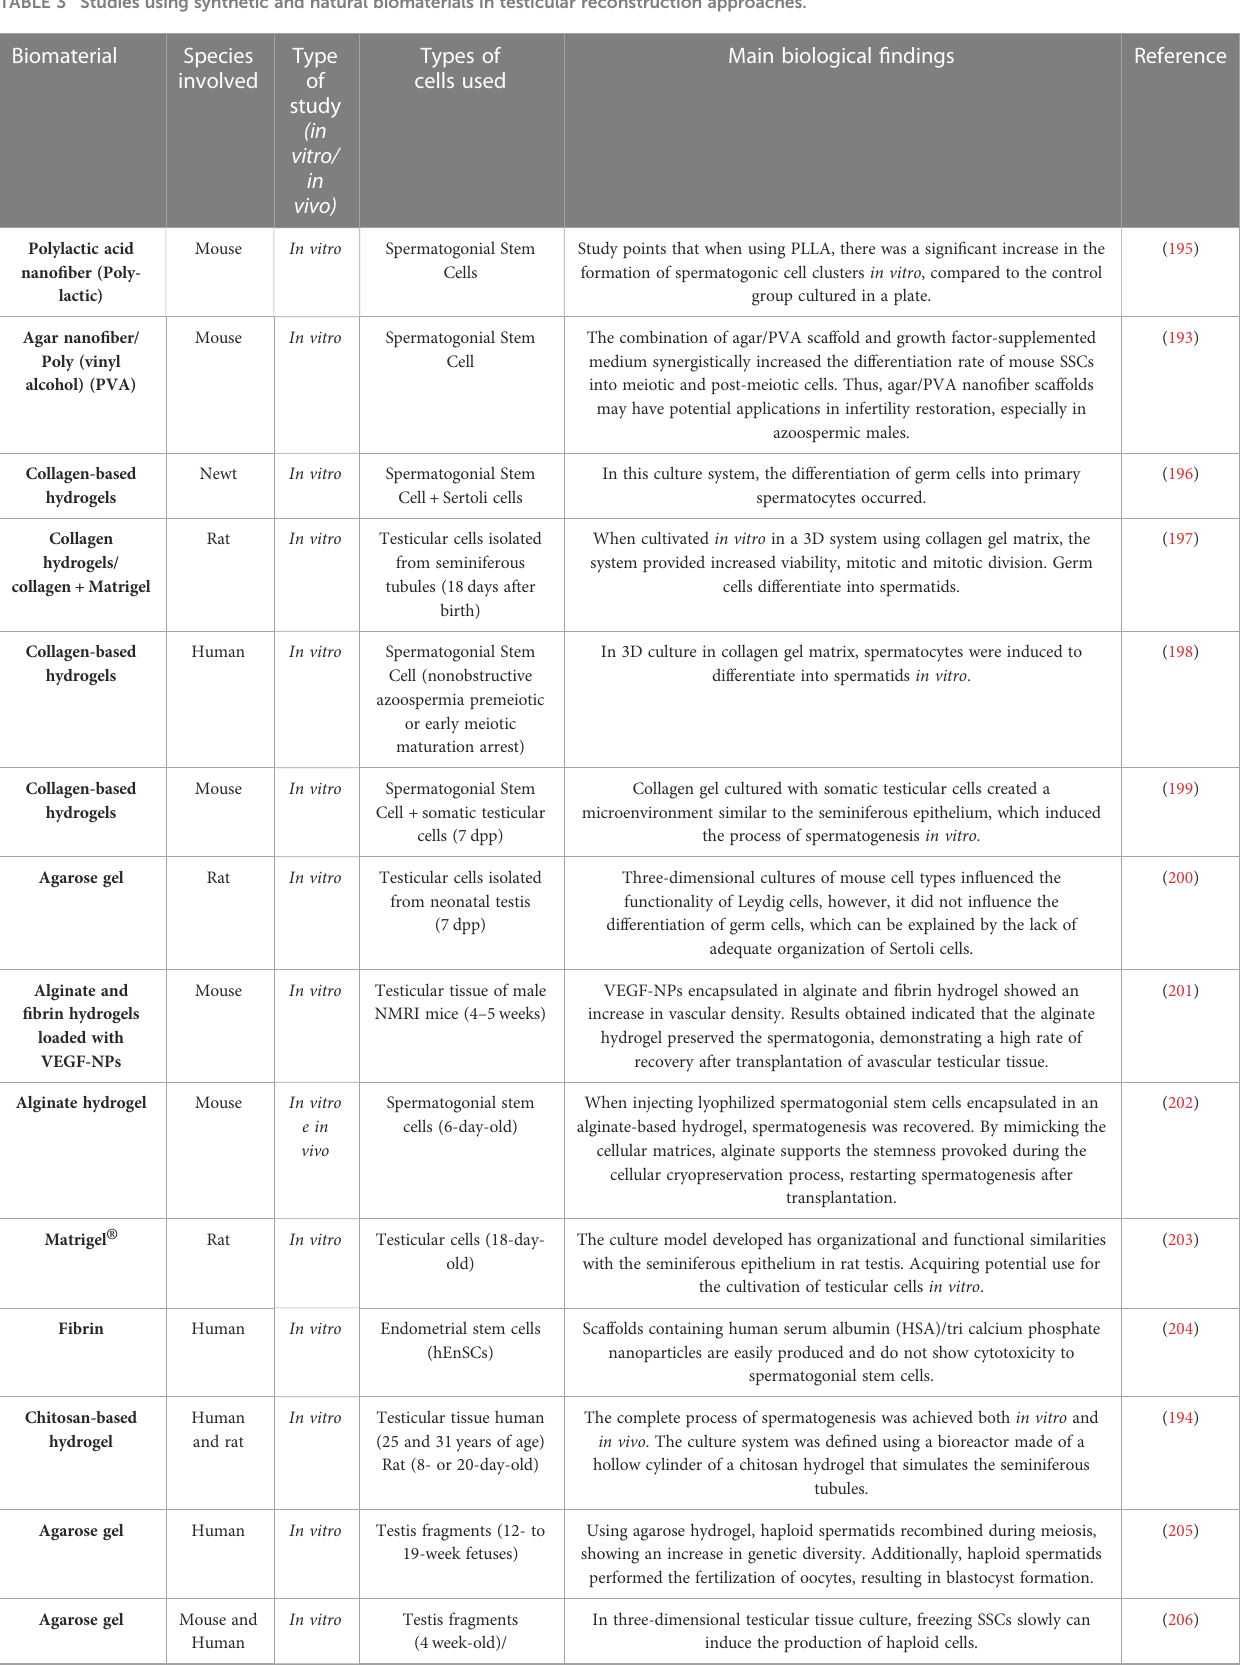
TABLE 3 Studies using synthetic and natural biomaterials in testicular reconstruction